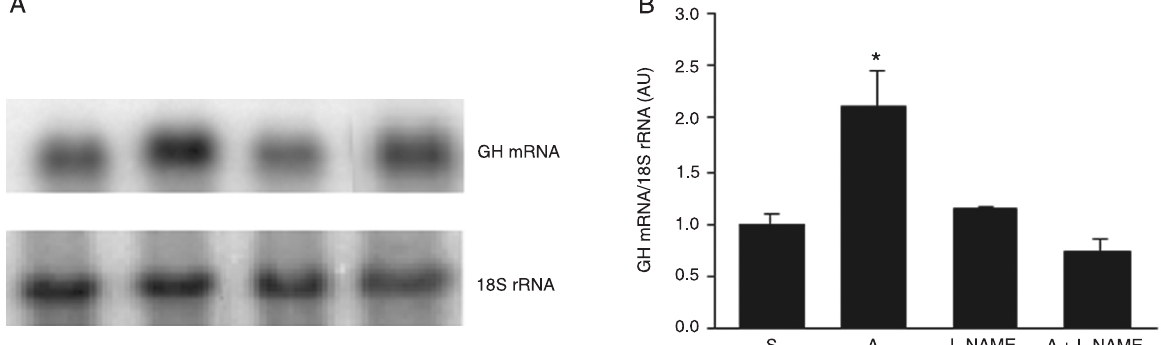
Figure 3. Effect of L-NAME plus arginine administration on growth hormone (GH) mRNA expression. A , Typical autoradiograms of the GH mRNA and 18S abundance obtained in one experiment of a total of three . B , Quantitative representation of hybridization of GH and 18S rRNA transcripts obtained in all experiments. Hemi-pituitaries were incubated for 1 h with saline (S) or 71 mM arginine (A) in the presence or absence of 55 mM L-NAME (L-NAME and A+L-NAME). The values obtained from blot densitometry were normalized by 18S rRNA. Data are reported as means ± SEM in arbitrary units (AU). *P < 0.001 vs all other groups (one-way ANOVA followed by the Student-Newman-Keuls test).